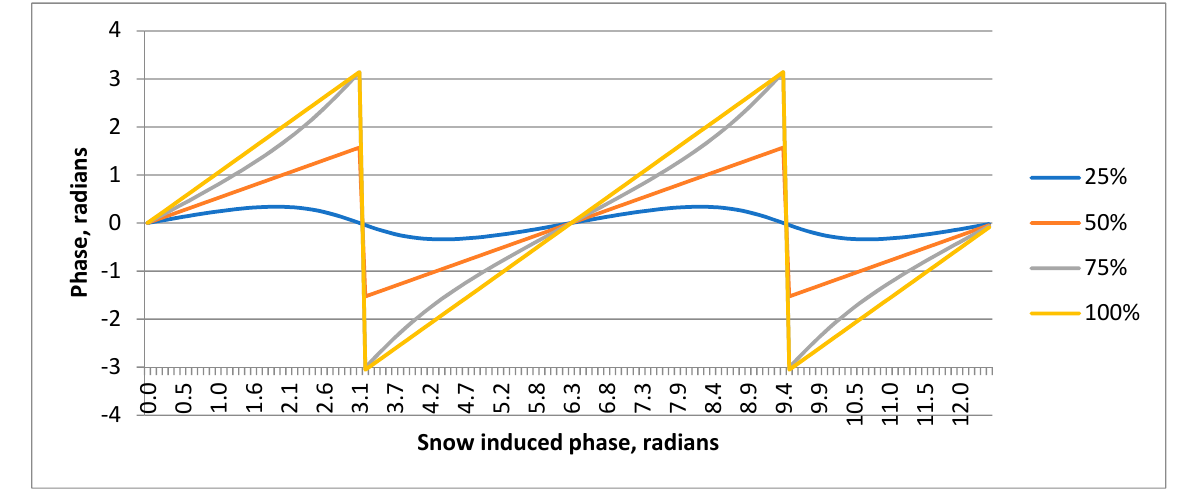
Figure 6. Phase of the signal scattered by the plate OB with respect to the snow induced phase for different percentages of snow cover.